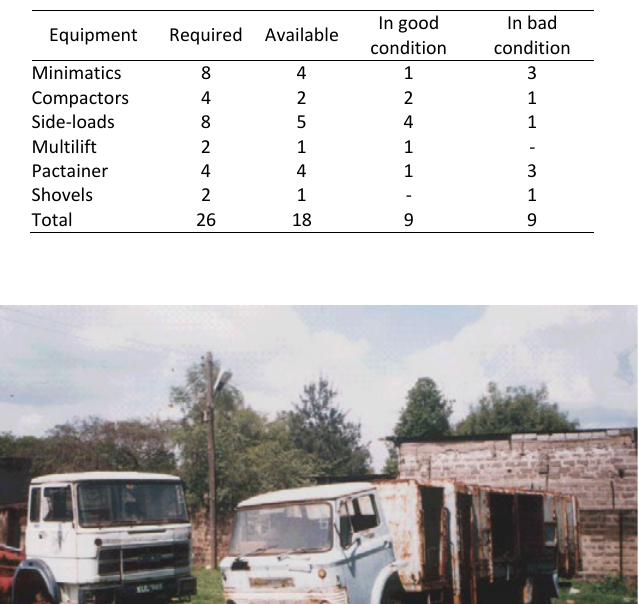
Table 6. Status of transportation vehicles (The Director of Environment and Enforcement, 2018)